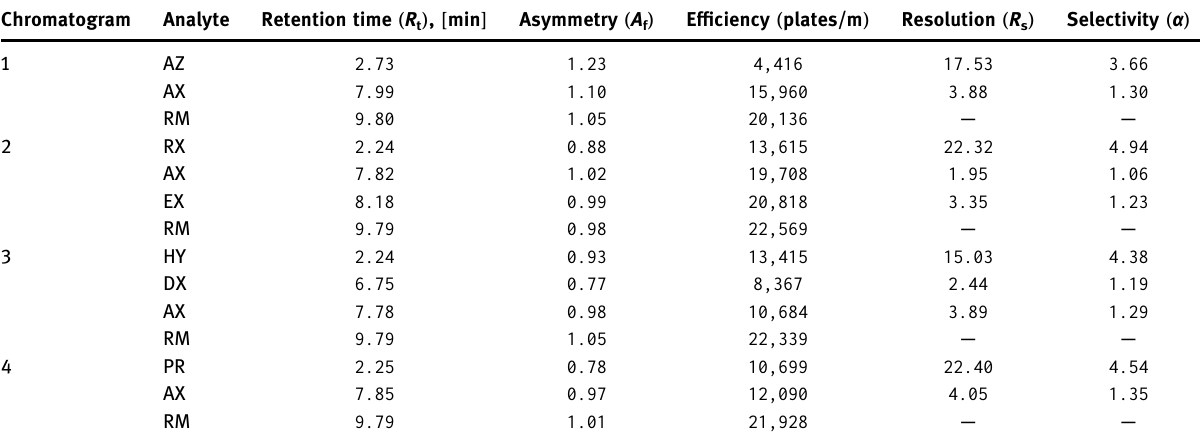
Table A1: System suitability parameters calculated for all separated analytes